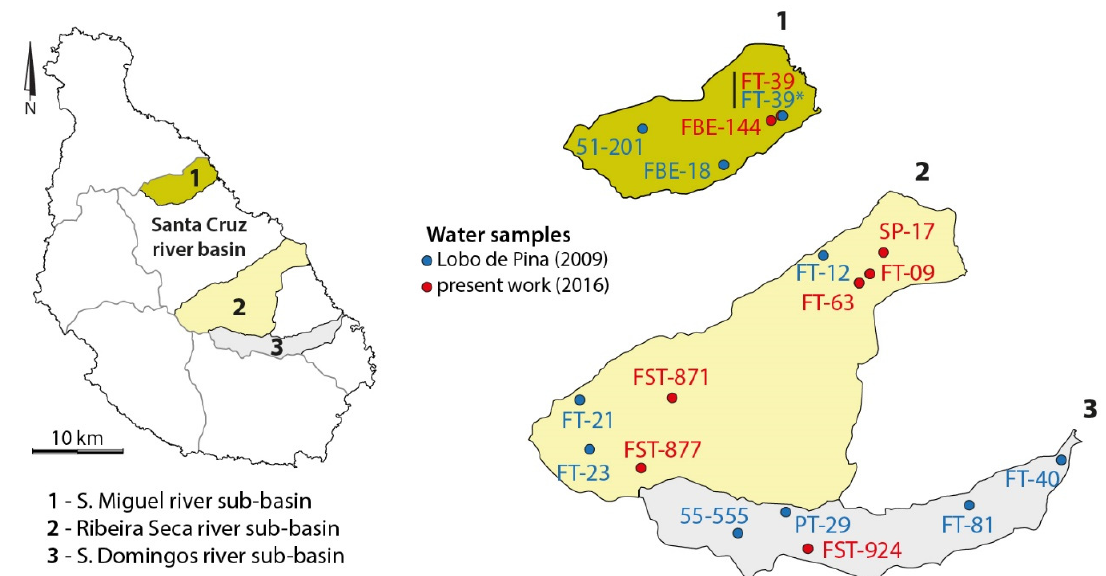
Figure 8. Distribution of sampling points for hydrochemistry study in S. Miguel, Ribeira Seca and S. Domingos river sub-basins. *—the FT-39 borehole is coincident in both works.